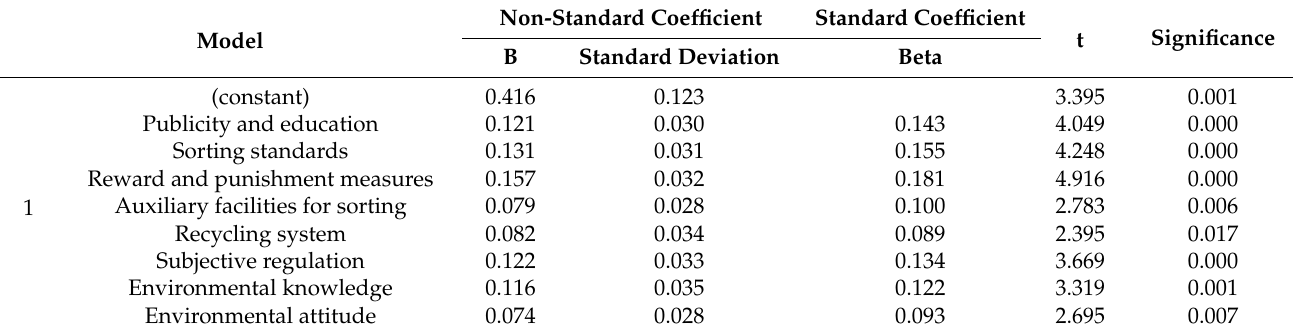
Table 20. Table of regression